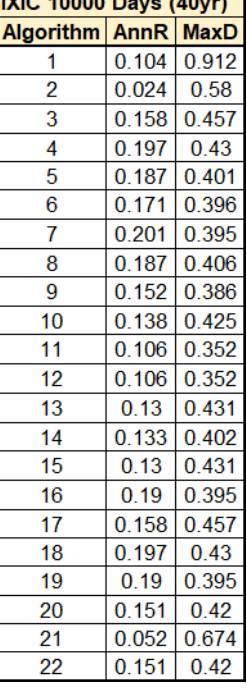
Figure 15. Performance of the suite of FastHedge algorithms on the IXIC index over the 10,000 trading days (about 40 years) ending 31 December 2022. The core settings used here are slightly different than those used in Figure 14, but our main point is that a large variety of the core algorithms performed very well, and had acceptable levels of maximum drawdowns. Furthermore, each of these algorithms was held fixed (including all other parameters) during the entire test. Moreover, the design of these algorithms is entirely generic, and they have not been tuned to any financial variable or time period. This is strong evidence against any charge of algorithm overfitting or data mining in our framework. Only a few of the algorithms actually underperform the IXIC index itself, and for reasons we understand fully. (No. 1 is the basic BnH, and does the